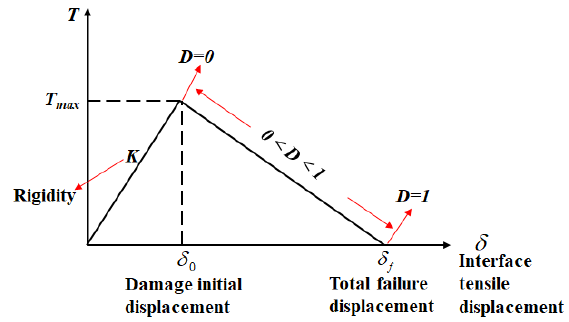
Figure 1. The traction-separation law of cohesive element.